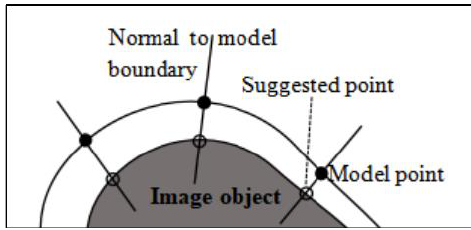
Figure 2. Simple principle ASM.